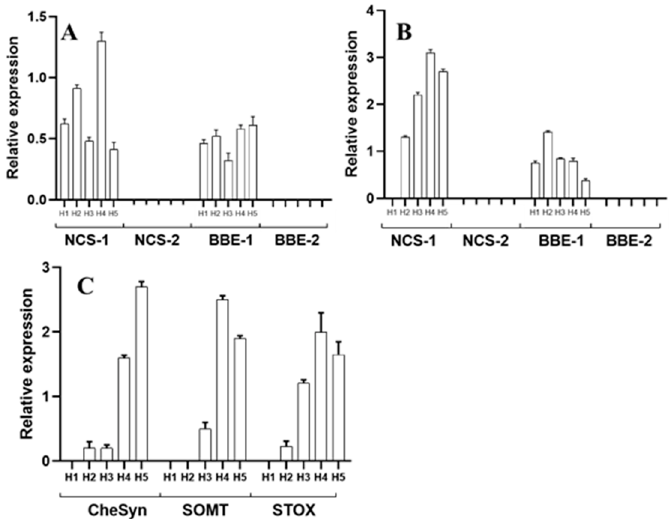
Figure 4. Relative abundance of the transcript involved in alkaloid biosynthesis in A. mexicana hypocotyls. The developmental stages correspond to H1 to H5, as shown in Figure 2A. ( A , B ) are the relative transcript abundance for NCS-1 and BBE-1 in the cotyledons and radicles, respectively. NCS-2 and BBE-2 were below the detection limits. ( C ) is the relative transcript abundance for SOMT , STOX and CYP71914 ( ChESYN ) in the radicles (the levels in cotyledons were undetectable). The average of triplicates with the standard deviation is given. ACTIN was used as the reference gene.